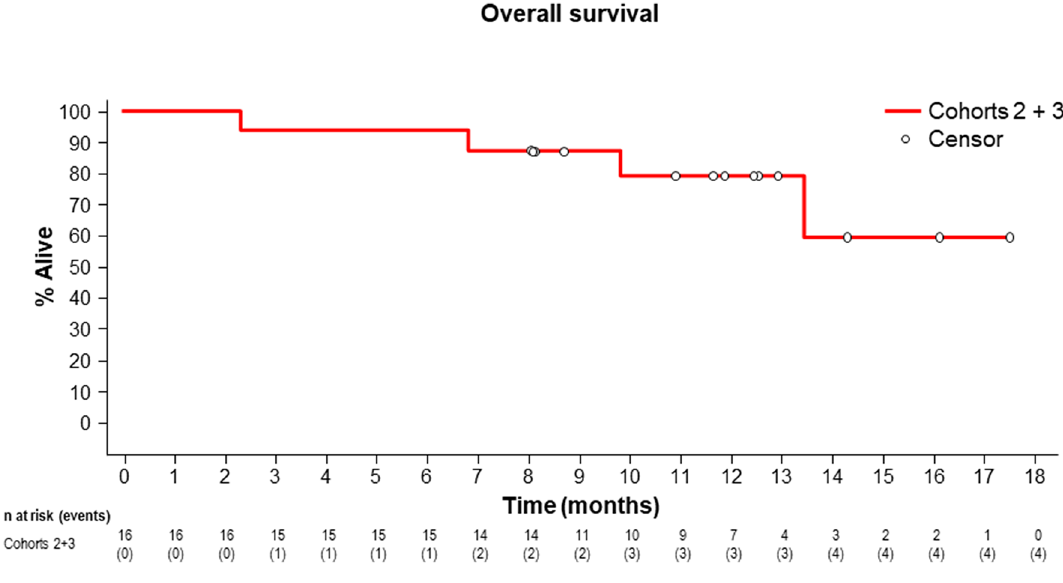
Figure 2. Kaplan–Meier curve of OS when cohorts 2 and 3 were